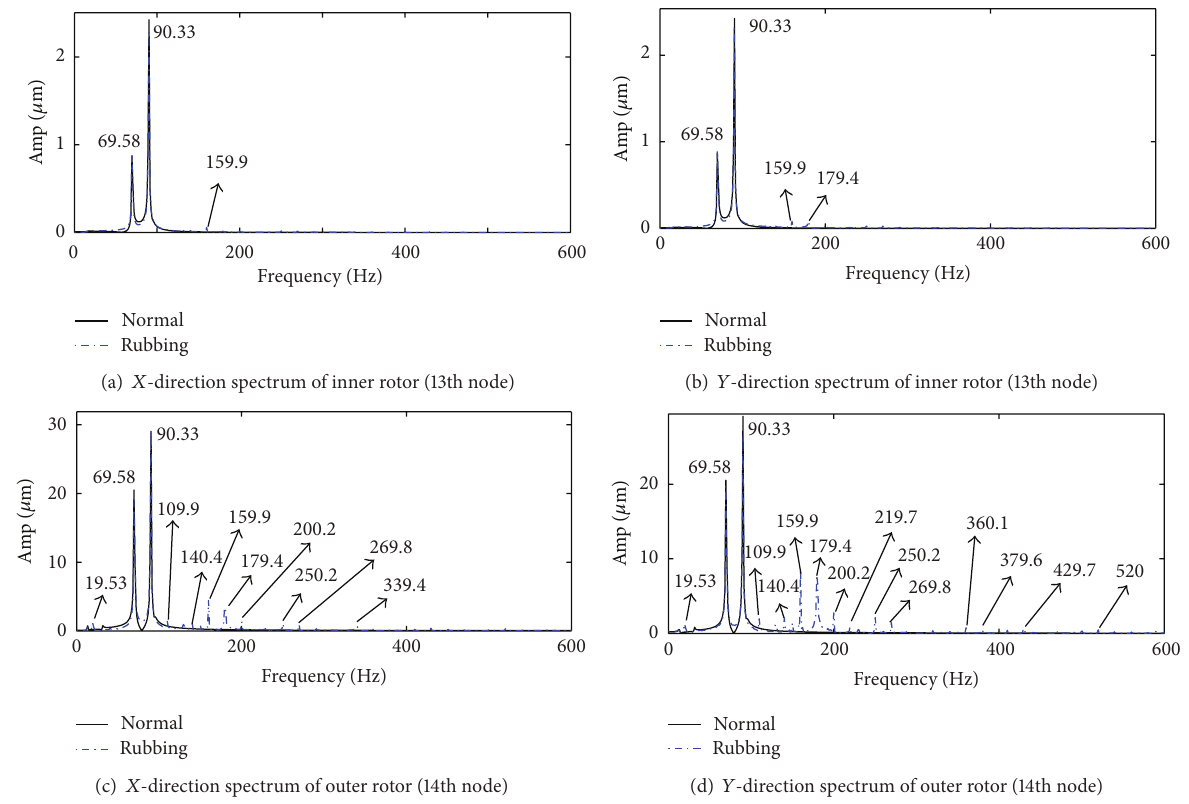
Figure 7: The vibration displacement spectrum of inner and outer rotors (rubbing location: outer rotor disc).